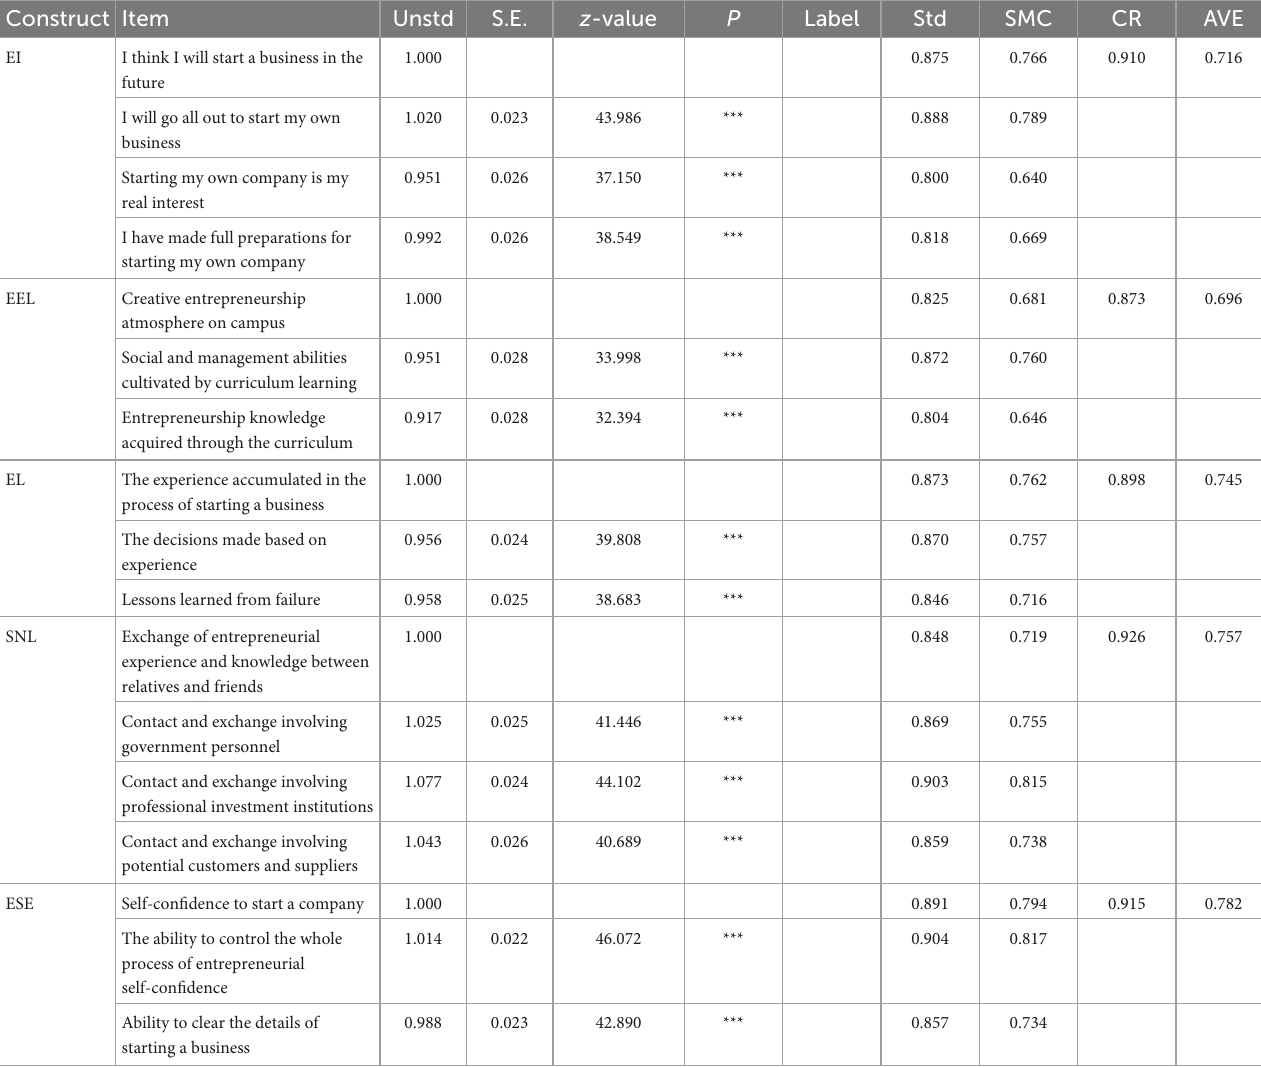
TABLE 2 Validation factor analysis for each dimension. Construct